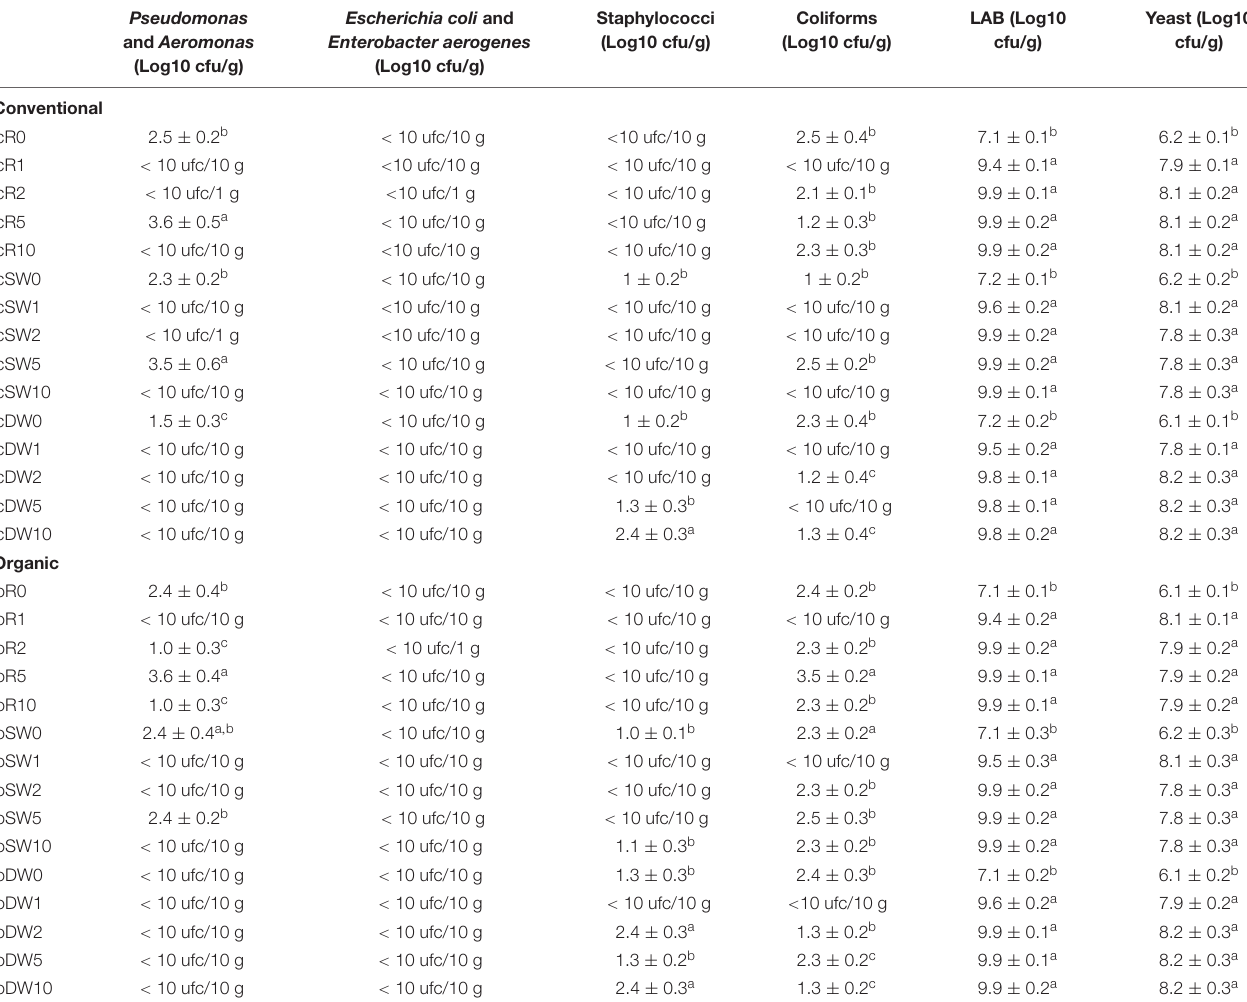
TABLE 2 | Microbial characterization of doughs prior (cR0, cSW0, cDW0, oR0, oSW0, and oDW0) and after 1 (cR1, cSW1, cDW1, oR1, oSW1, and oDW1), 2 (cR2, cSW2, cDW2, oR2, oSW2, and oDW2), 5 (cR5, cSW5, cDW5, oR5, oSW5, and oDW5), and 10 (cR10, cSW10, cDW10, oR10, oSW10, and oDW10) days of